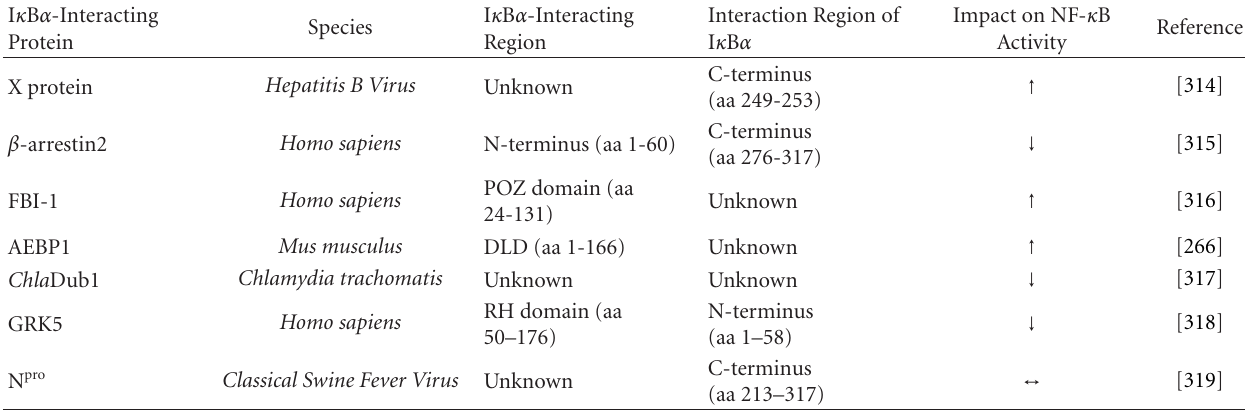
Table 1: I κ B α -Interacting Proteins and Impact on NF- κ B